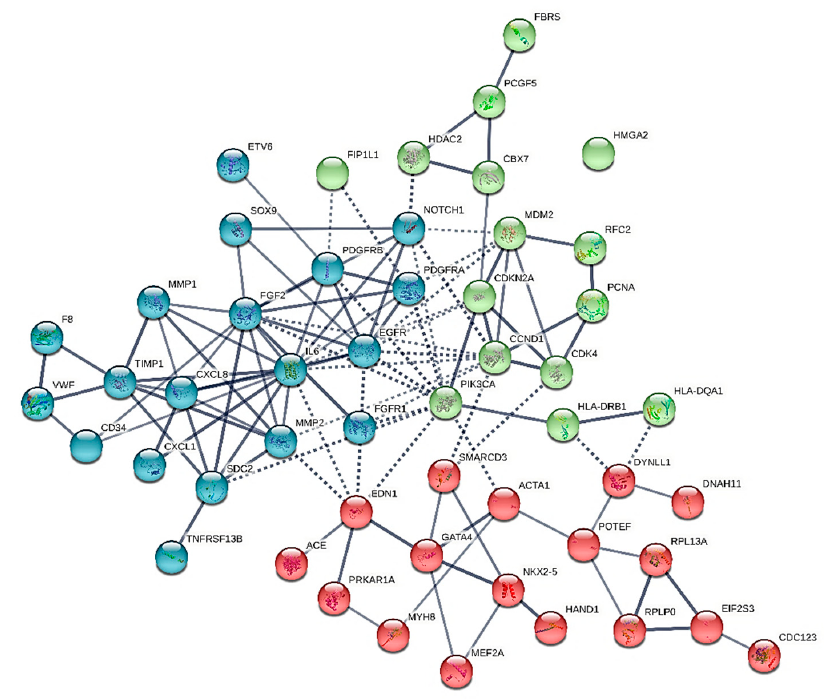
Figure 2. The heart undifferentiated sarcoma interactome.